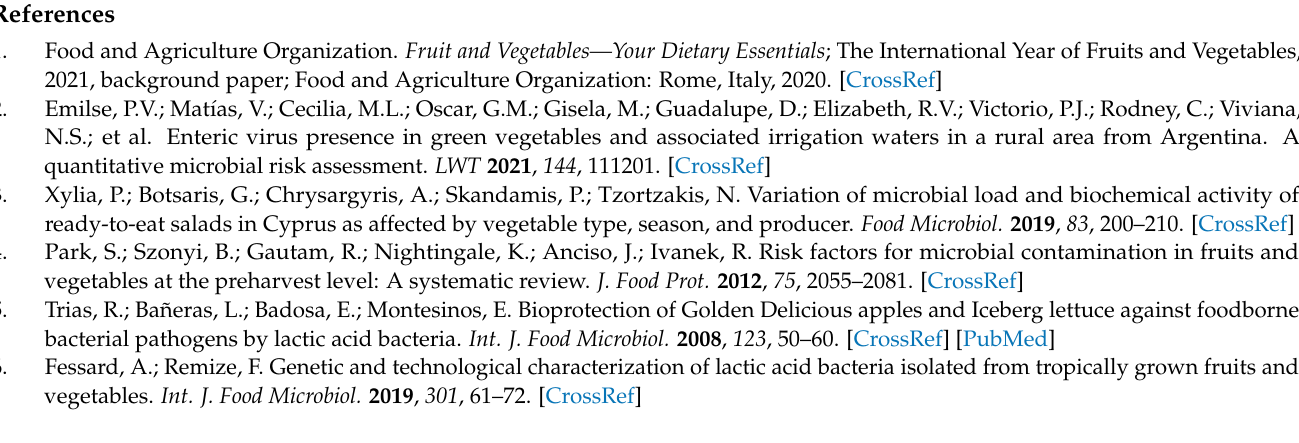
R23. Legend: Lanes 1 to 3: peptide bands stained with Coomassie Blue R250 with 40% saturated ammonium sulfate (lane 1); 60% saturated ammonium sulfate (lane 2); 80% saturated ammonium sulfate (lane 3); lane 4: molecular mass marker; lane 5: zone of growth inhibition, corresponding to the position of the peptide bands in lane 1; lane 6: zone of growth inhibition, corresponding to the position of the peptide bands in lane 2 and lane 7: zone of growth inhibition, corresponding to the position of the peptide bands in lane